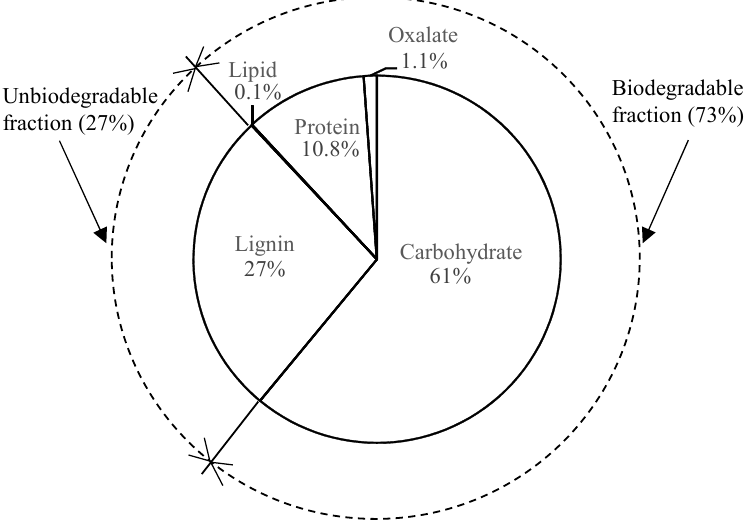
Figure 1. Dry fodder biomass component analysis results.